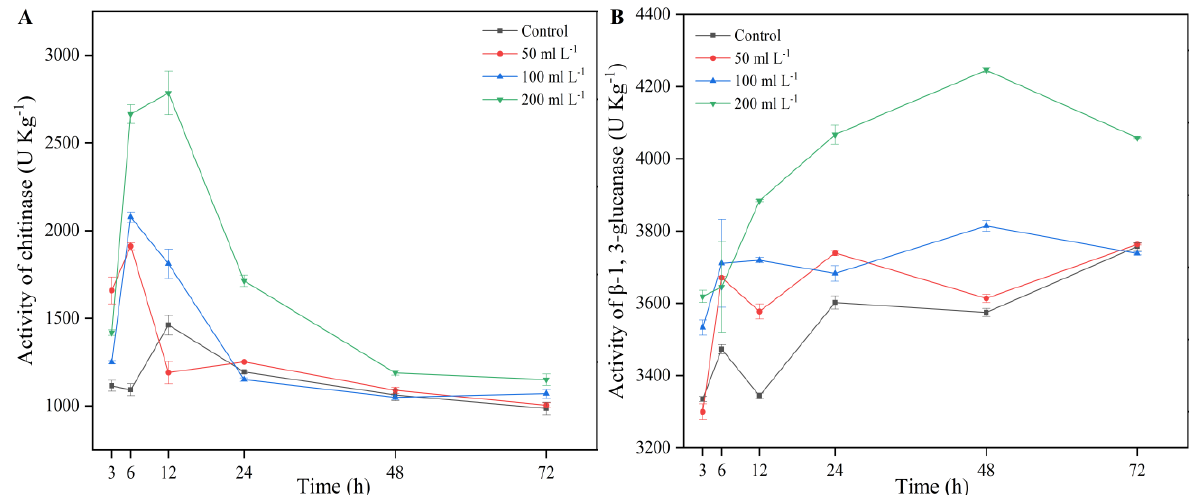
Figure 11. Detection of chitinase ( A ) and β -1, 3-glucanase ( B ) activities in cell wall of A. alternata after treatment with 50 mL L − 1 , 100 mL L − 1 , and 200 mL L − 1 aseptic filtrate for 3 h, 6 h, 12 h, 24 h, 48 h, and 72 h. Data are displayed as the mean ± SE.